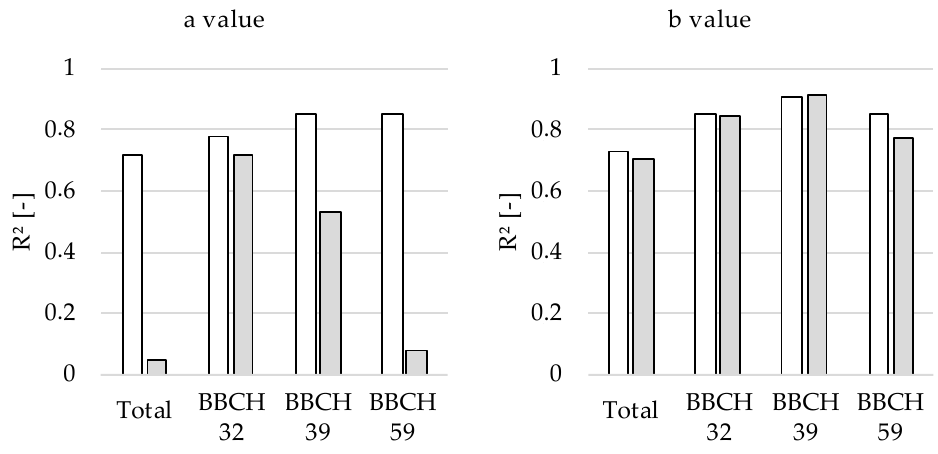
Figure 7. Coefficients of determination (R²) between plant coverage and reflection channels of the TrueColor sensor.